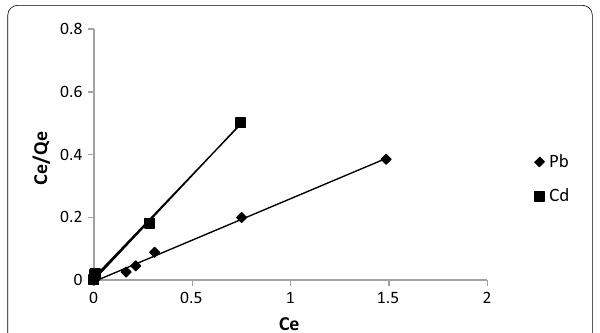
Fig. 8 Langmuir sorption isotherms of Pb(II) and Cd(II) ions by modified Amberlite XAD-4